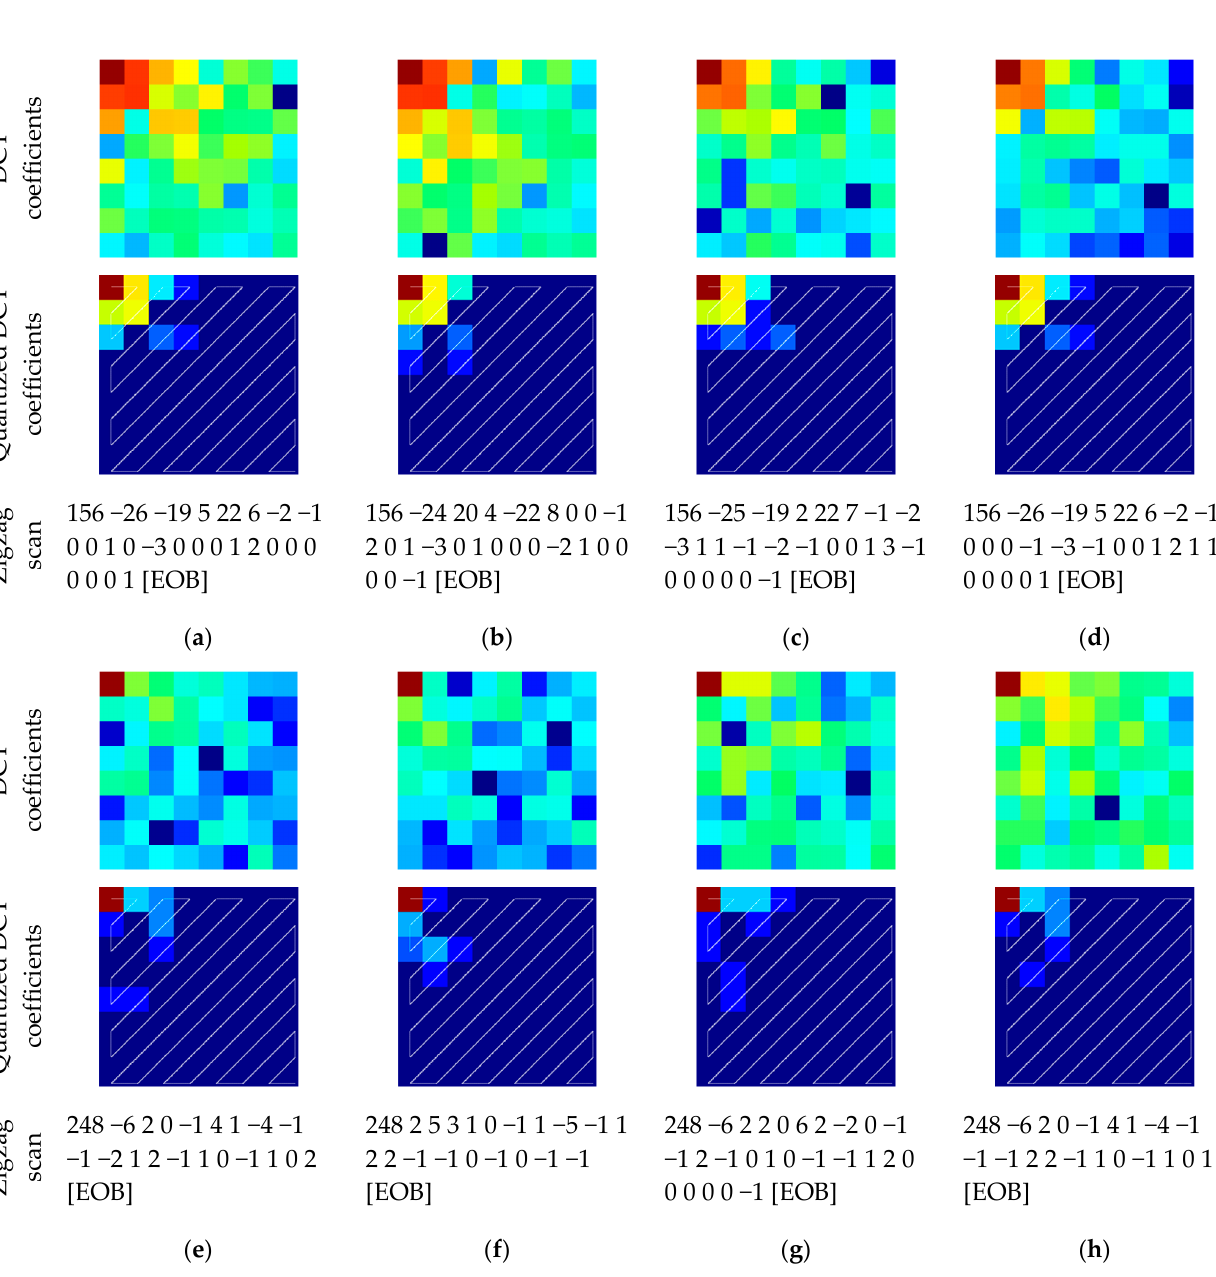
Figure 12. The CPE scheme compressibility analysis based on the DCT energy compaction. ( a – d ) The DCT of the block where correlation coefficients were σ h = 0.95 and σ v = 0.96. ( e – h ) The DCT of the block where correlation coefficients were σ h = 0.49 and σ v = 0.52. ( a , e ) The original block transformations. ( b , f ) The scrambled block transformations obtained by processing the entire blocks. ( c , g ) The scrambled block transformations obtained by the sub-block (4 × 4) processing. ( d , h ) The scrambled block transformations obtained by the sub-block (2 × 2) processing.